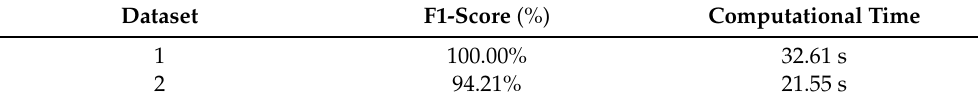
Table 3. F1 Score (%) and computational time by a single core Intel(R) Xeon(R) CPU @ 2.20 GHz.